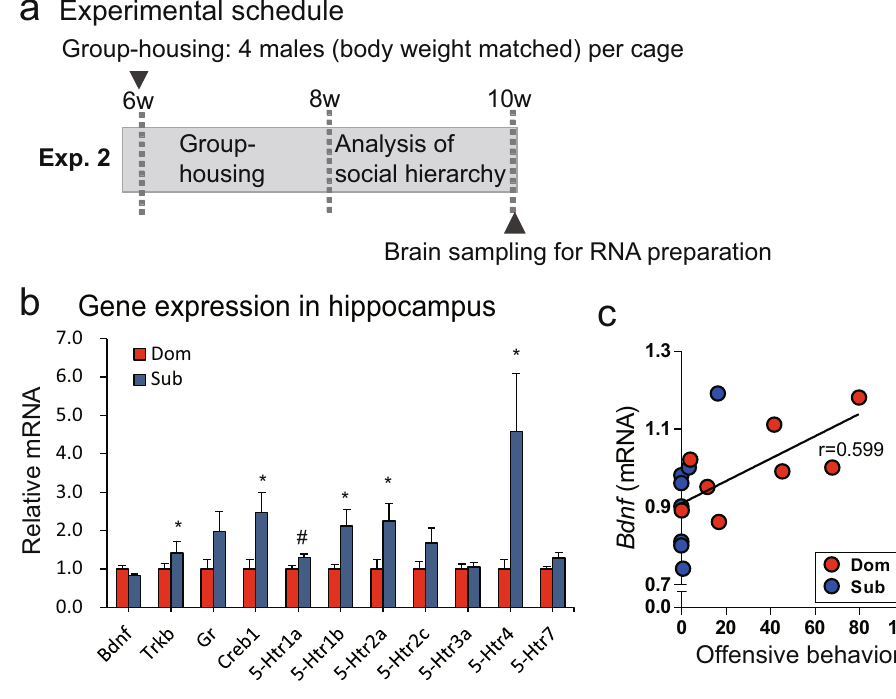
Figure 4. Comparison of gene expression levels in the hippocampi of dominant and subordinate males. ( a ) Experimental schedule. Brains were collected when the mice were aged 10 weeks. ( b ) Expression of genes associated with anxiety- and depression-like behaviour and adult neurogenesis in the hippocampi of dominant (Dom) and subordinate (Sub) males ( # P < 0.1, * P < 0.05). ( c ) Correlation between Bdnf expression and aggressive behaviour